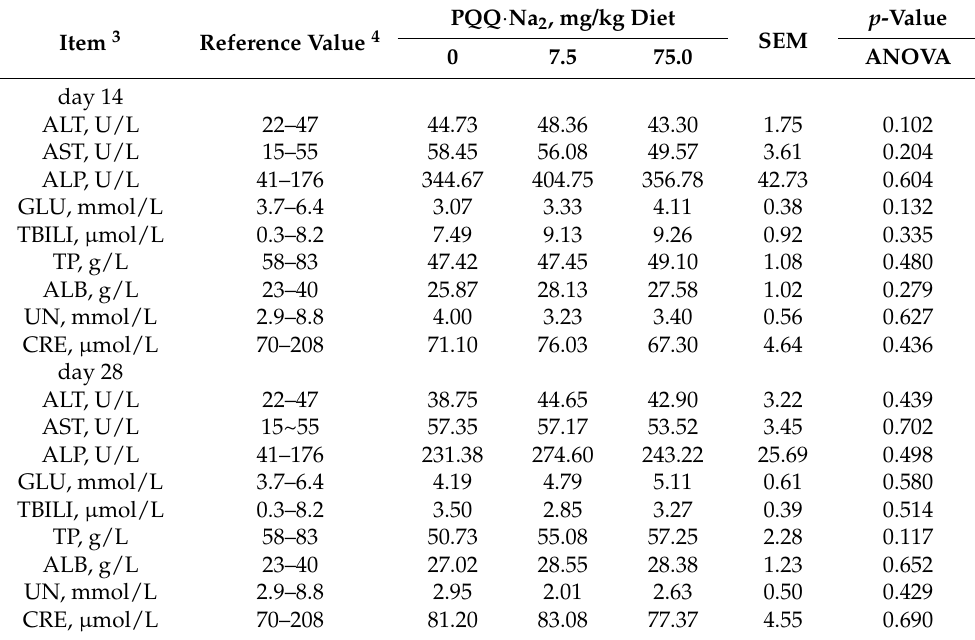
Table 5. Effects of graded levels of PQQ · Na 2 1 on serum biochemical parameters of weaned piglets